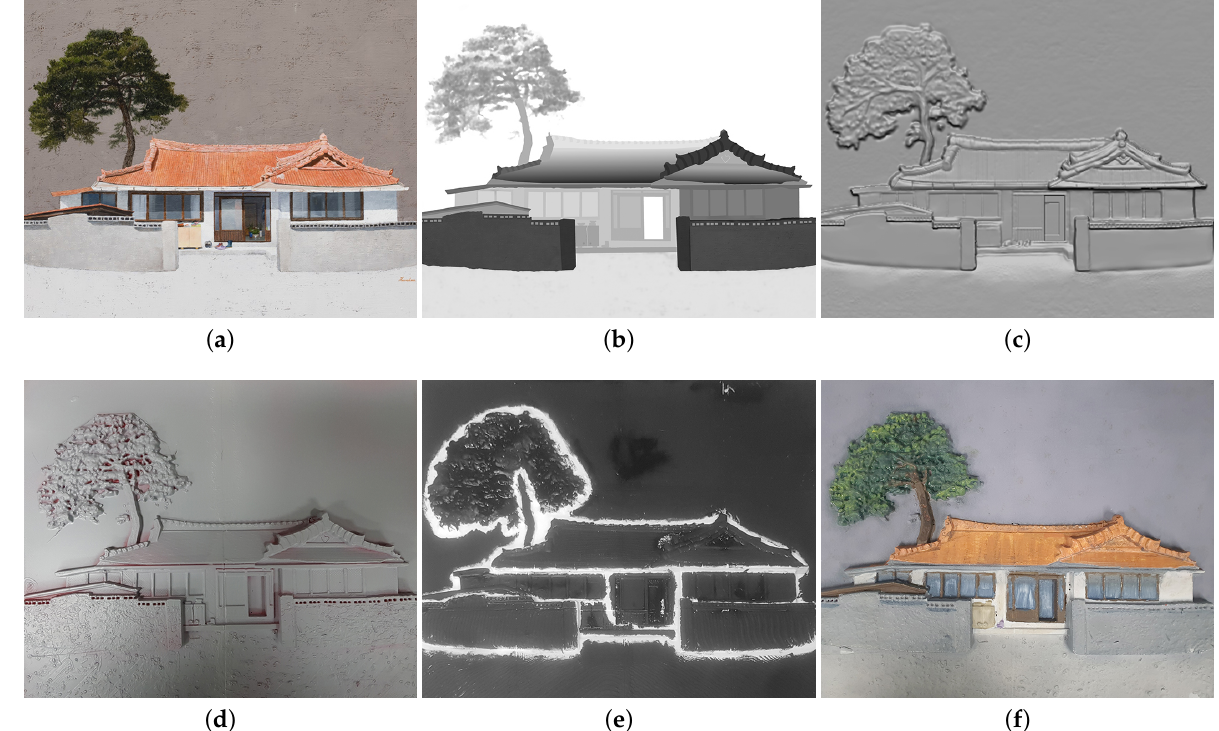
Figure 1. Touch sensitive 2.5D relief model fabrication process. ( a ) Original image; ( b ) Grey scale height-map; ( c ) 2.5D digital model; ( d ) 2.5D printed model; ( e ) Conductive paint coat ( f ) Completed 2.5D relief